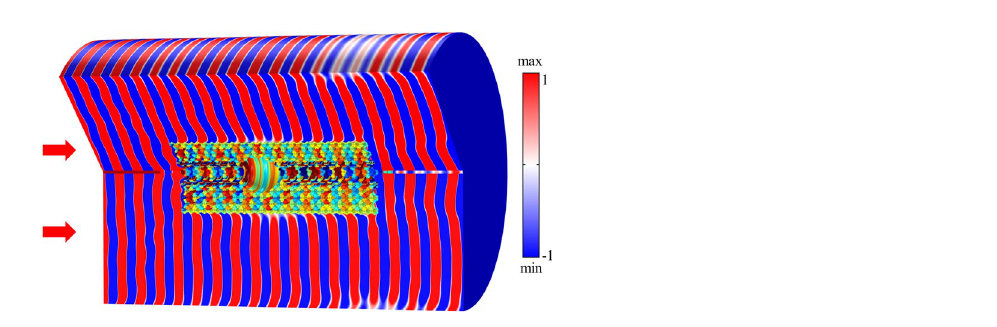
Figure 8. The acoustic pressure field with a spherical cloaking effect in the 3D axisymmetric